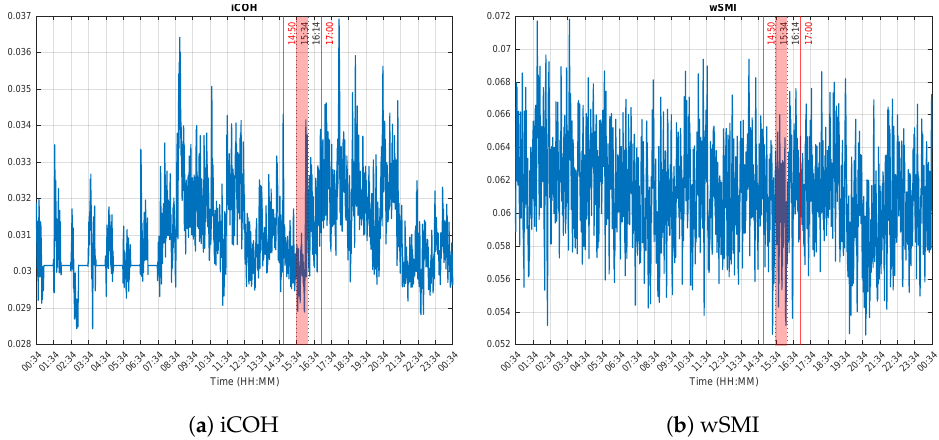
Figure 5. Connectivity features. The experiment was performed between 14:50 and 17:00 (red vertical lines). The dotted lines at 15:34 and 16:14 delimit ∆ t , the time during which the experimenter reported that the patient was correctly answering the questions he was asked. The values of the iCOH appear lower during night time (20:00 to 08:00 + 1 ), suggesting a lower consciousness level during that time. A decrease is also observed between 12:30 and 15:34 before slowly increasing afterwards. wSMI values on the other hand show little variations with a decreasing tendency as the time goes.